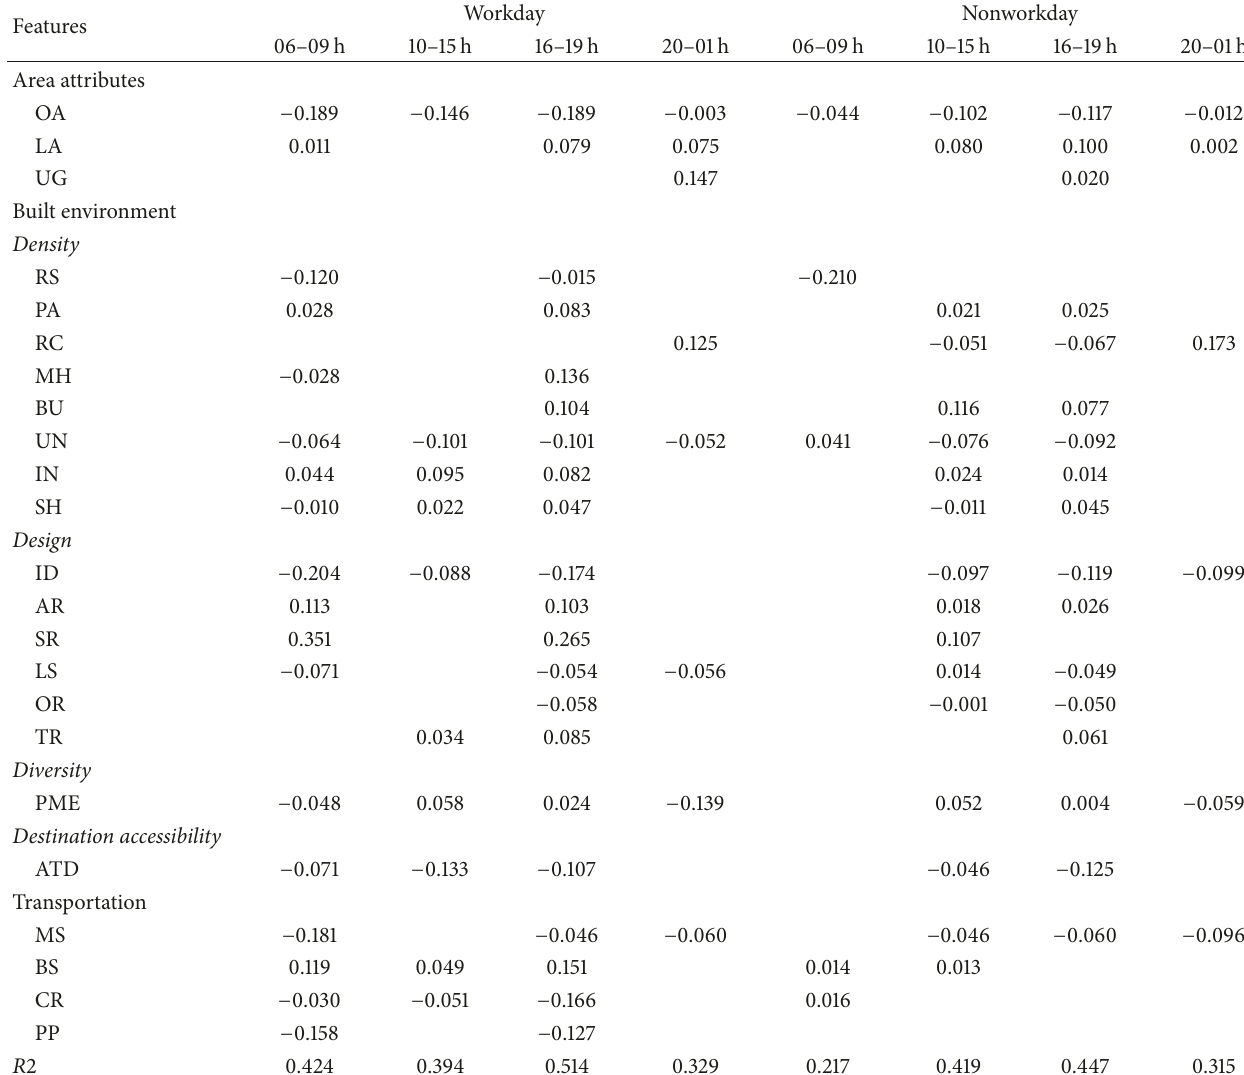
Table 4: The results of imbalance